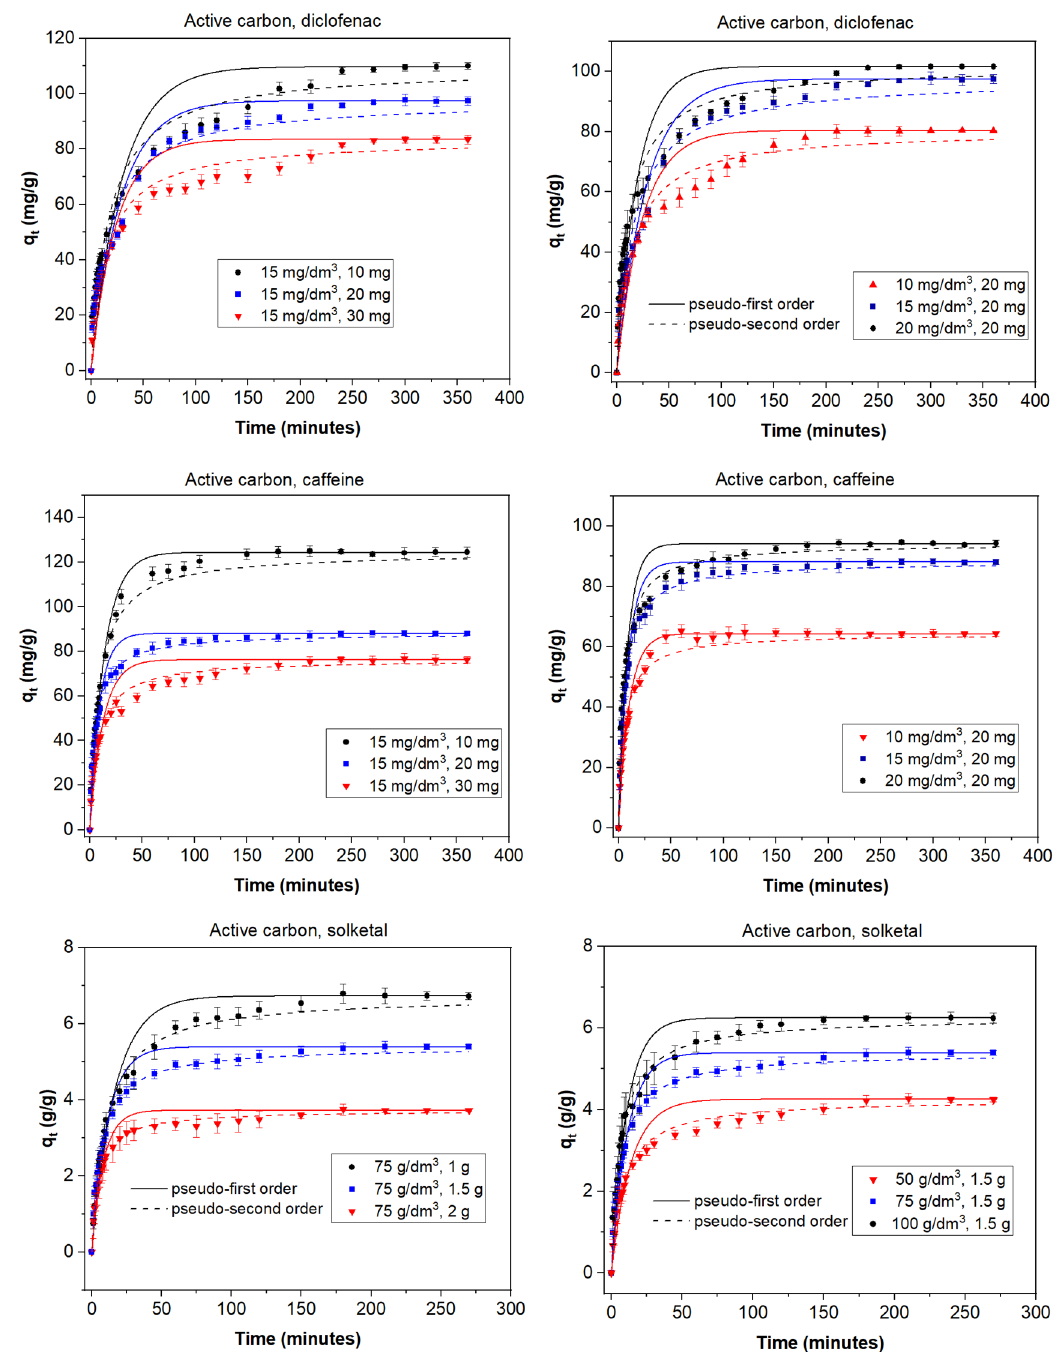
Figure 1. Kinetic adsorption data for diclofenac, caffeine, and solketal on AC using various absorbate concentrations (10–20 mg/dm 3 ; 50–100 g/dm 3 ) and adsorbent amounts (10–30 mg; 1–2 g). T = 298 K.